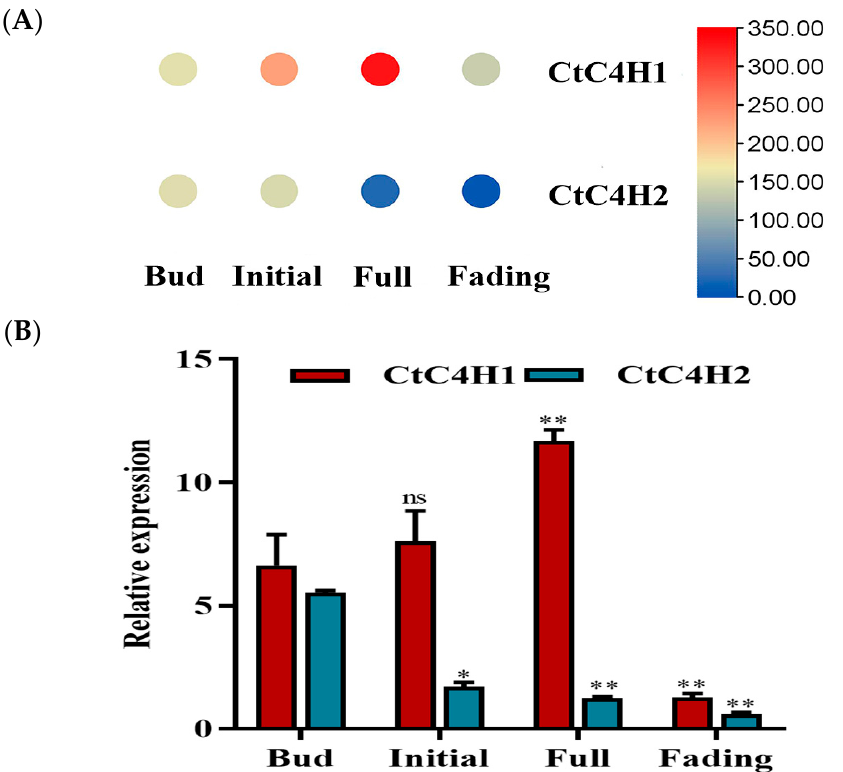
Figure 1. Expression profiling of two candidate CtC4H-encoding genes in different flowering stages of safflower. ( A ) The heat map demonstrates the expression level of CtC4H1 and CtC4H2 genes in four different flowering stages of safflower (bud, initial, full, and fading) using the FPKM ratios obtained from transcriptomic data. ( B ) The validation of the relative expression level of CtC4H1 and CtC4H2 genes in different flowering stages of safflower was determined using qRT-PCR analysis. The statistics were calculated with one-way ANOVA test and significant differences between treatments were demonstrated with asterisk ( ns no significant, * p < 0.05, ** p < 0.01).